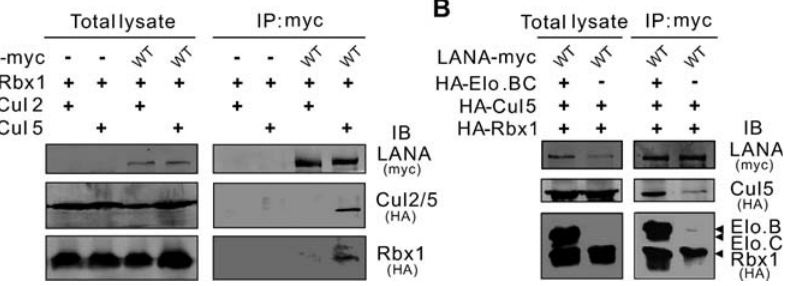
Figure 2. The LANA–Elongin BC Complex Assemble with the Cul5/Rbx1 Module (A) LANA protein associates with the Cul5/Rbx1 module but not Cul2/Rbx1 module, and (B) Elongin BC complex increases interaction of LANA with the Cul5/Roc1 module. Saos-2 cells were transfected with expression vector encoding the indicated proteins in the figure. The lysates underwent IP using anti-myc antibodies. Crude extracts (left panels) and immune complexes (right panels) were separated by SDS-PAGE and IB with the indicated